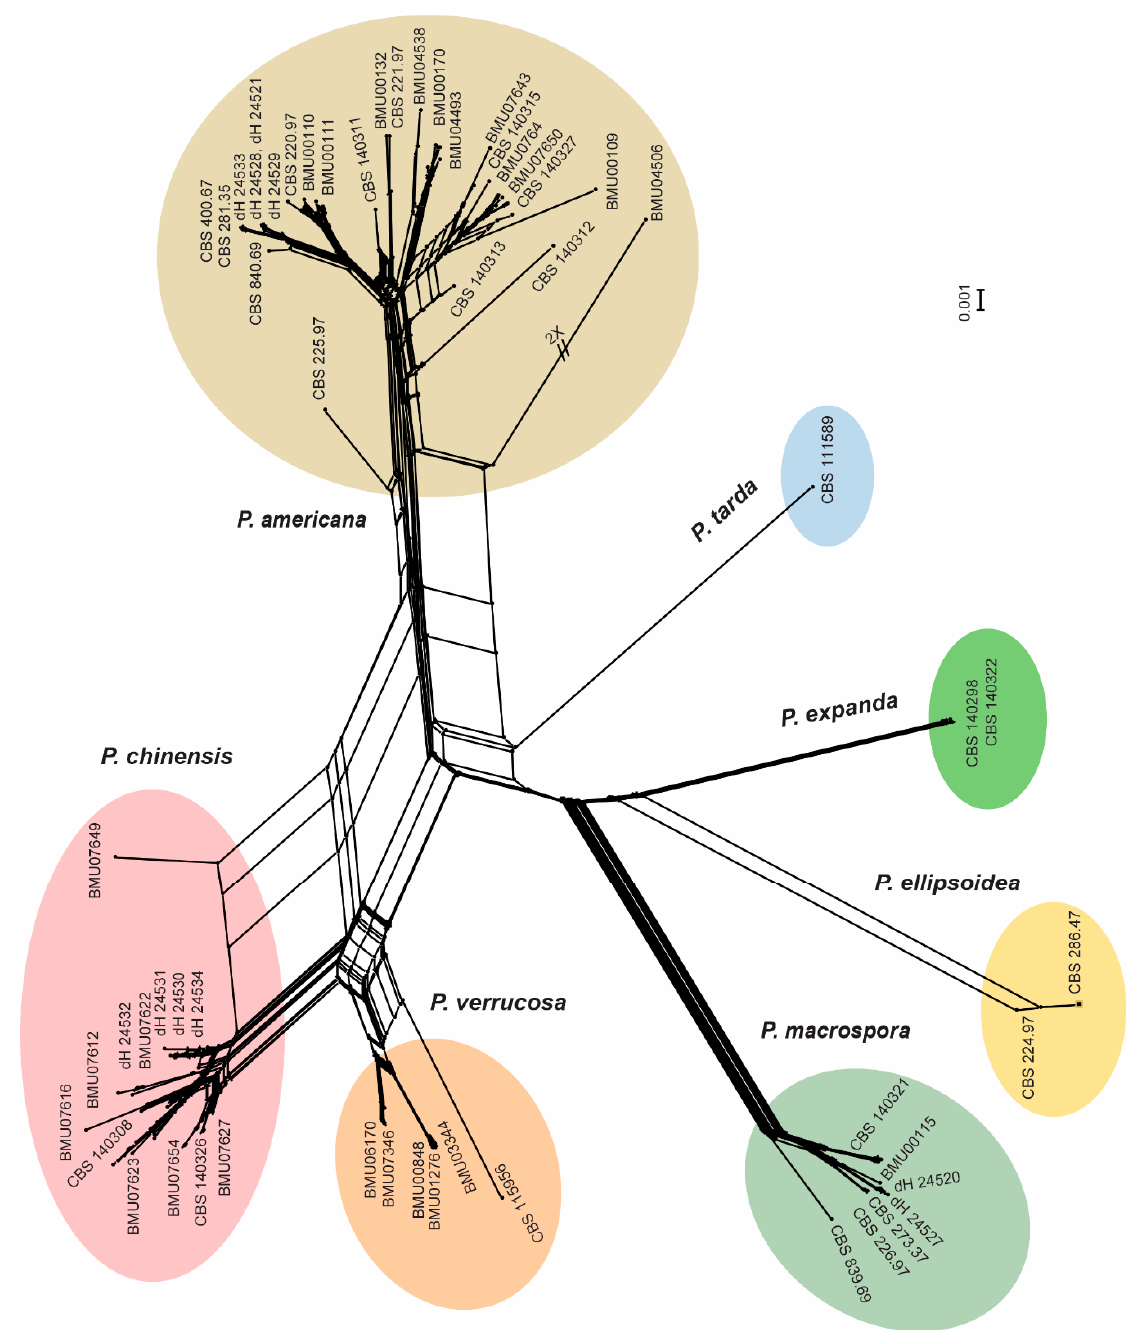
Figure 5. Neighbor-Net split decomposition network of Phialophora species based on ITS and TUB2 sequences of 139 strains. The splits between branches in the network indicate the locations of incongruence and the possibility of recombination. Some of the names of taxa were removed to enhance the clarity of the graph.